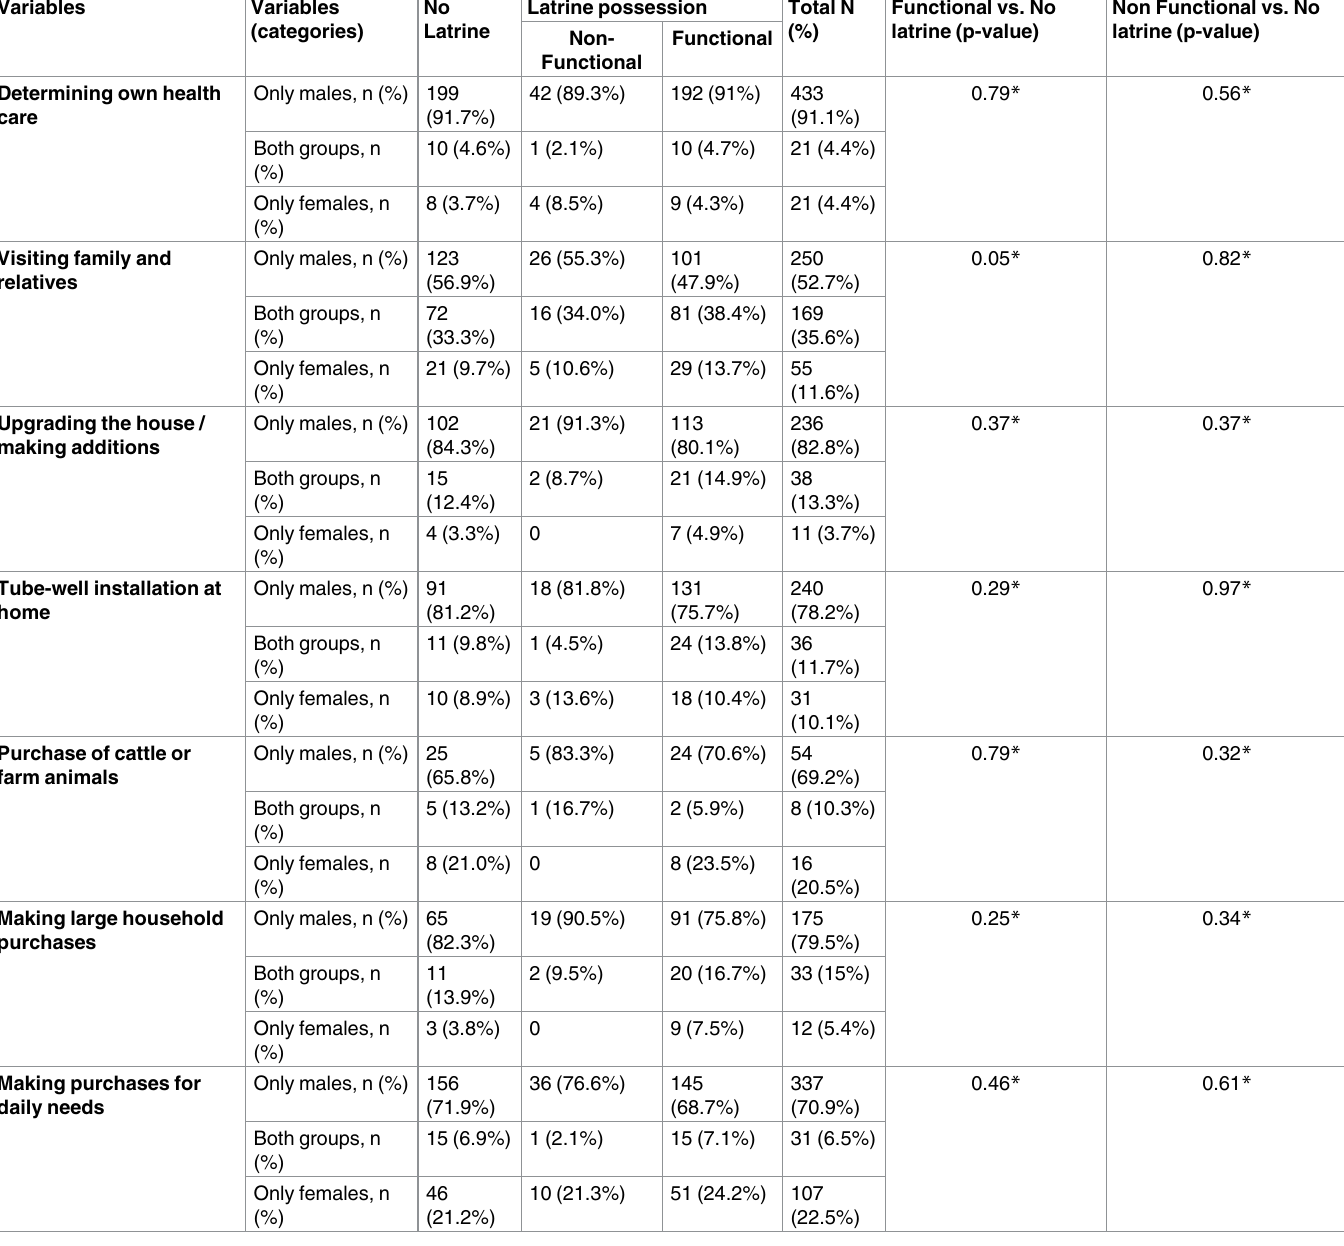
Table 3. Women’s involvement in decision making of their own personal lives and household items (n =